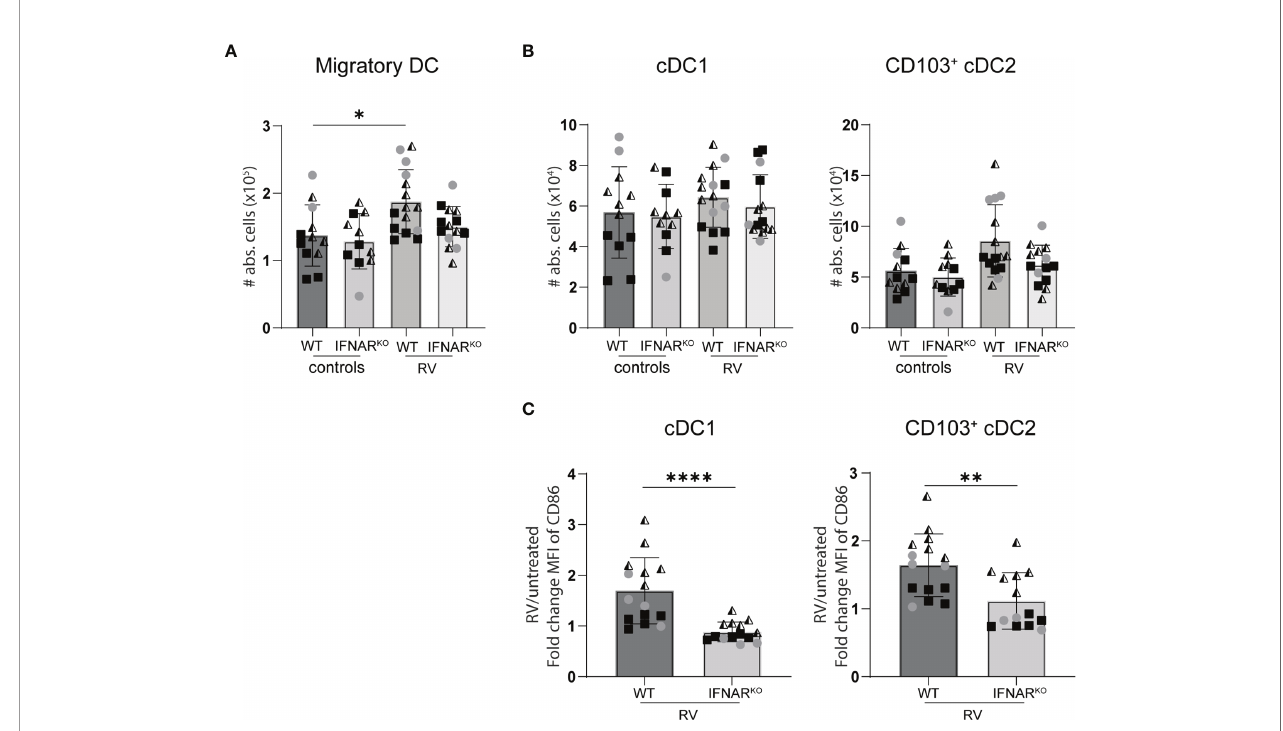
FIGURE 5 | Lack of IFNAR signaling did not alter the migration of dendritic cell to the small intestine draining MLN. WT and IFNAR KO mice were infected with RV and four days post oral infection the small intestine draining MLN were collected and analysed by fl ow cytometry. (A) Absolute cell number of migratory DCs (Lineage - CD64 - CD11c + MHCII high ). (B) Absolute number of cDC1 (CD103 + CD11b - ) and cDC2 (CD103 + CD11b + ). (C) Fold change of MFI of CD86 from cDC1 and cDC2 from RV-infected mice versus WT control mice. Ordinary one-way ANOVA with Tukey´s multiple comparison test was performed for statistical analysis of (A , B) . Mann Whitney U test was used for panel (C) . *p < 0.05, **p < 0.01, ***p < 0.001, ****p <